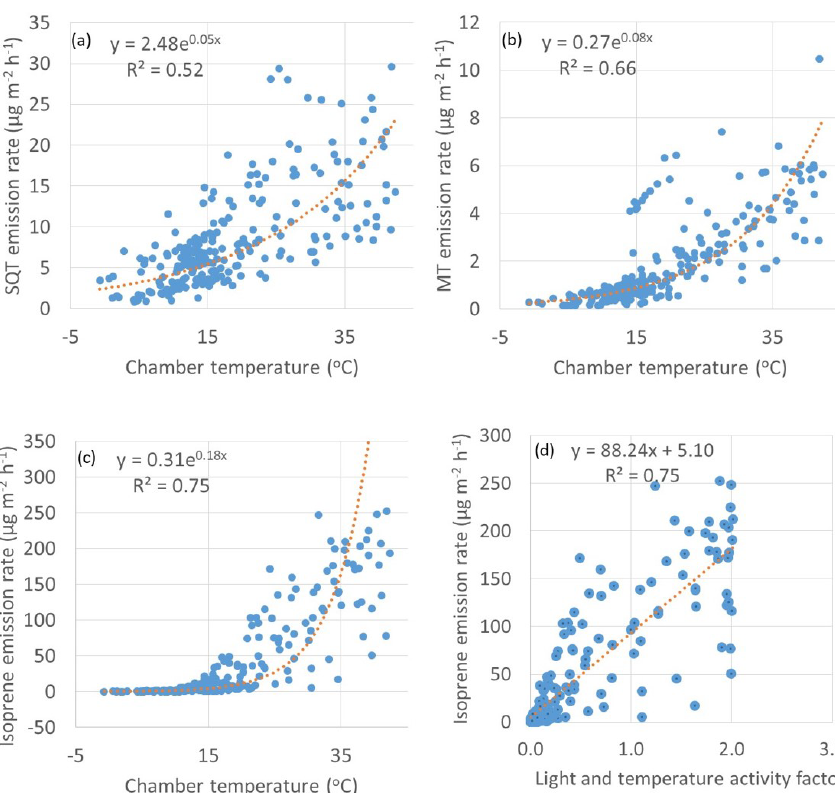
Figure 4. Exponential correlations of temperature with emission rates of (a) SQTs, (b) MTs and (c) isoprene and (d) linear correlation of light and activity coefficient (Guenther et al., 1993) with emission rates of isoprene. R 2 values for the plots (a) – (c) are from the corresponding transformed straight lines (ln( y ), ln( x )).